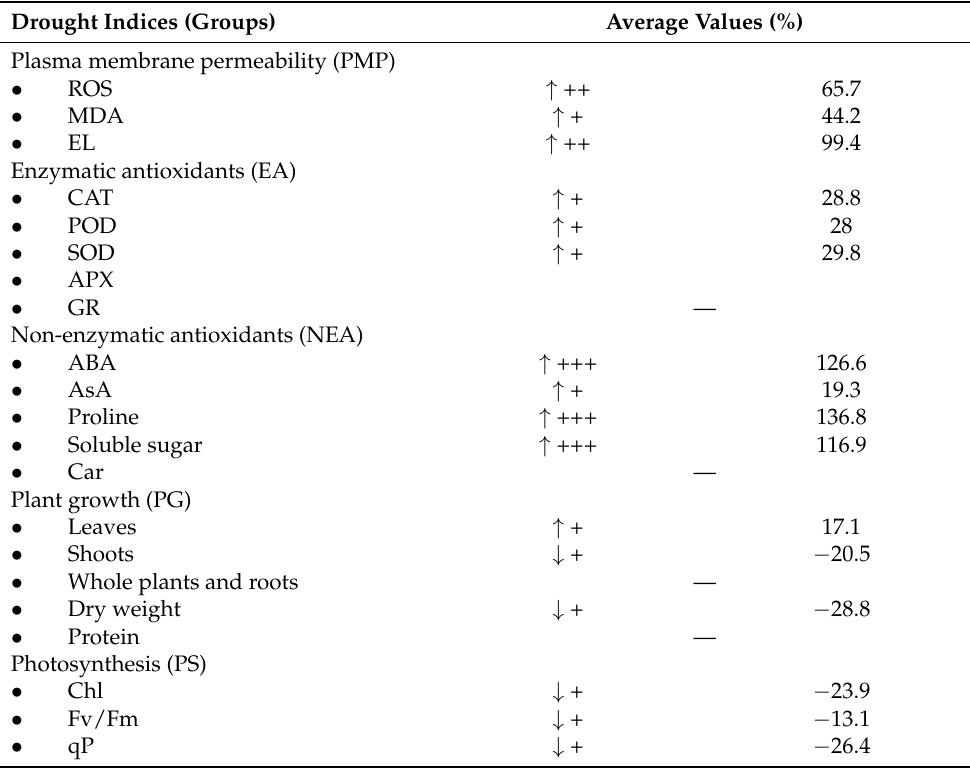
Table 2. Plant morphology, physiology, and functionalities in response to drought, according to studies by Sun et al.